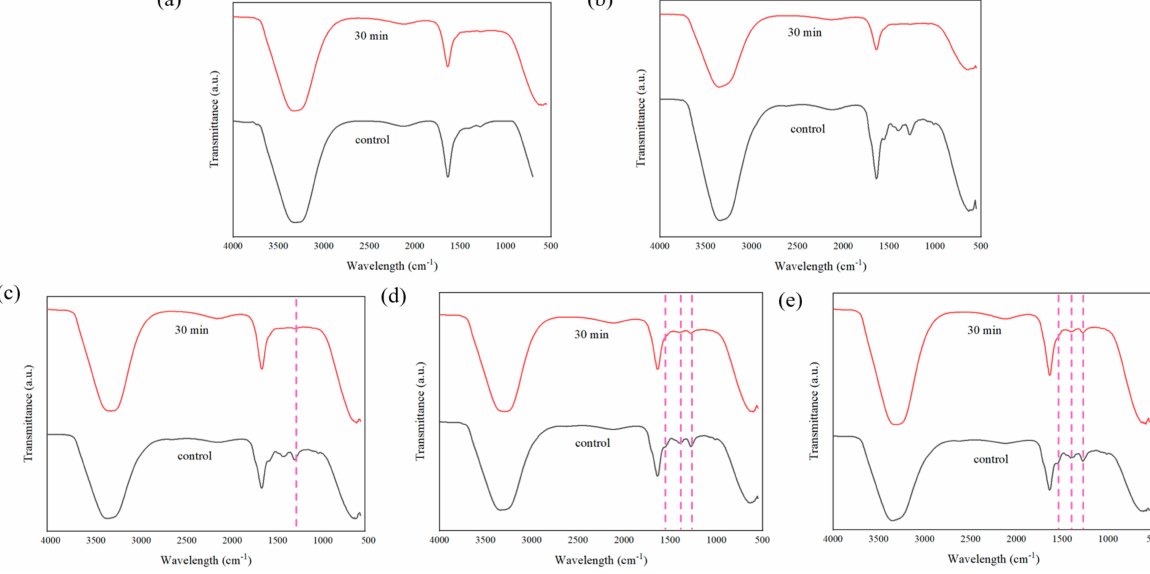
Figure 17. ATR–FTIR plots of fabricated porous hydrogels after 30 min immersion in PBS solution where ( a ) 0% PEDOT: PSS, ( b ) 0.5% PEDOT: PSS, ( c ) 1.0% PEDOT: PSS, ( d ) 1.5% PEDOT: PSS and ( e ) 2.0% PEDOT: PSS hydrogels